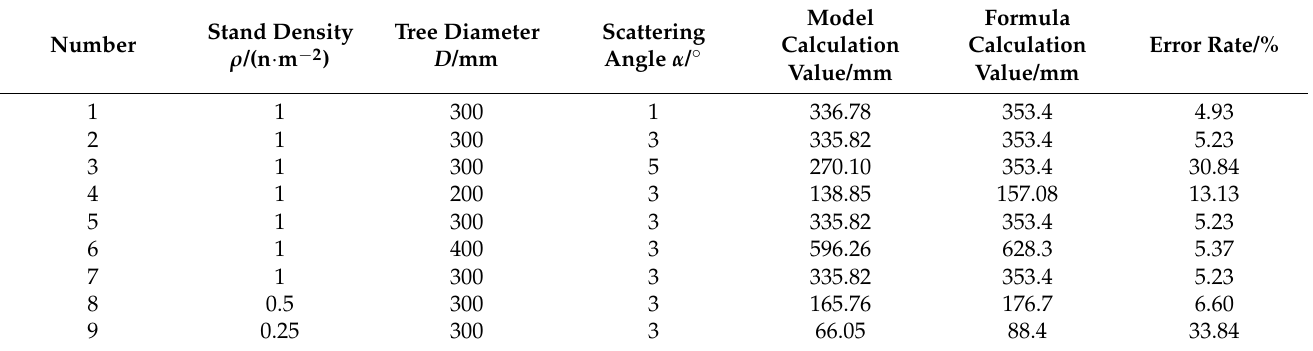
Table 4. Comparison between model calculation value and formula calculation value under different